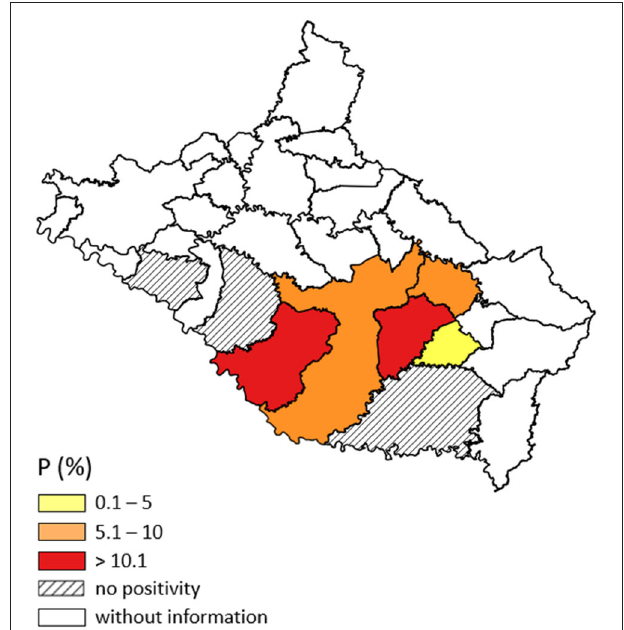
FIGURE 1 | Map of the distribution of bovine fasciolosis in the eight municipalities of the Serrana Mesoregion of Santa Catarina (SC) evaluated in the present study. Prevalence found in cattle analyzed in the field, in random properties, from 2019 to